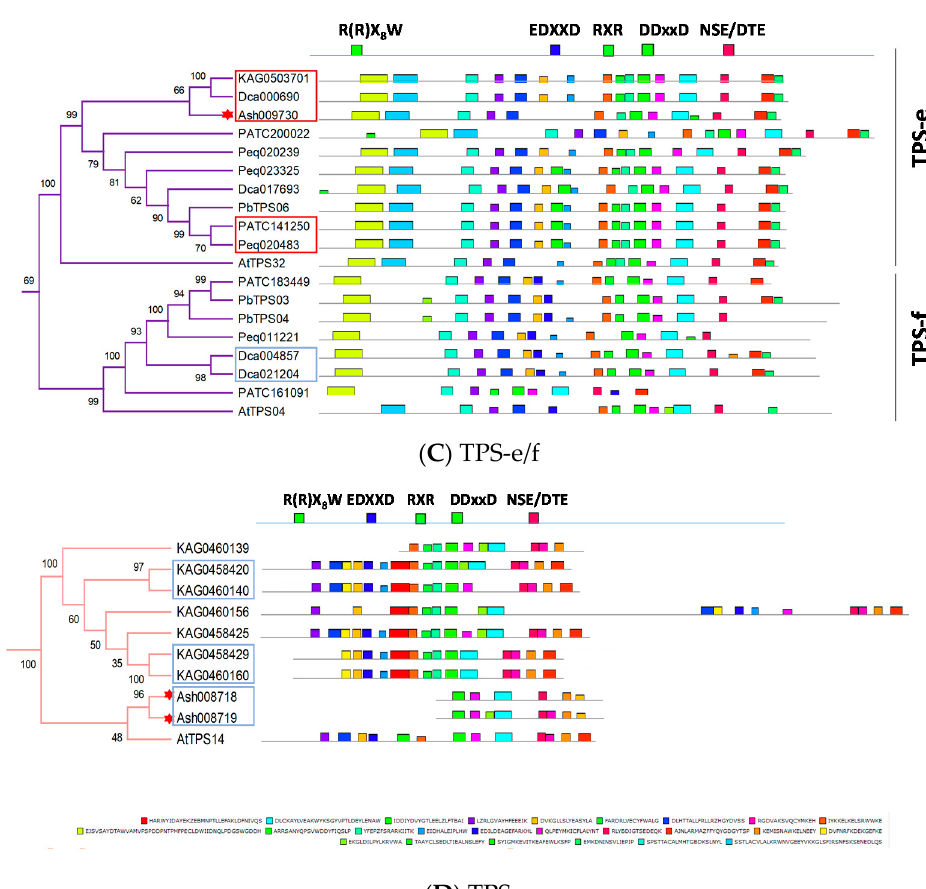
Figure 4. Motif structures of TPS proteins. ( A – D ) are TPS-a, -b, -e/f , and -g subfamilies, respectively. Twenty-five classical motifs in TPS proteins were analyzed by using the MEME tool. The width of each motif ranged from 6 to 50 amino acids. Different color blocks represent distinct motifs. Star indicates TPS s of A. shenzhenica , and the red solid circle indicates the out group of Apostasia TPS s. The red and blue rectangle squares reveal orthologous and paralogous gene pairs, respec- tively.